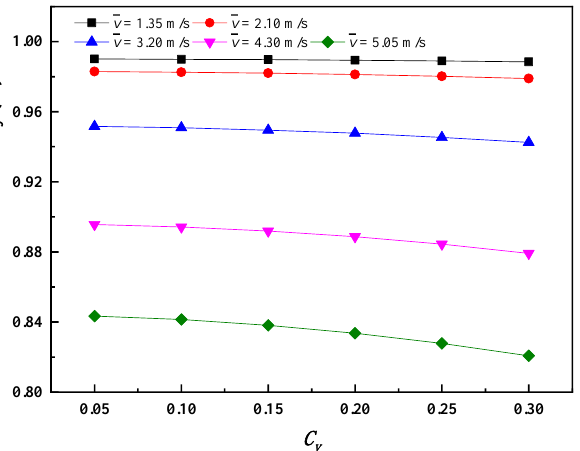
Figure 40. Relationship between relative standard deviation of velocity and denitration efficiency.